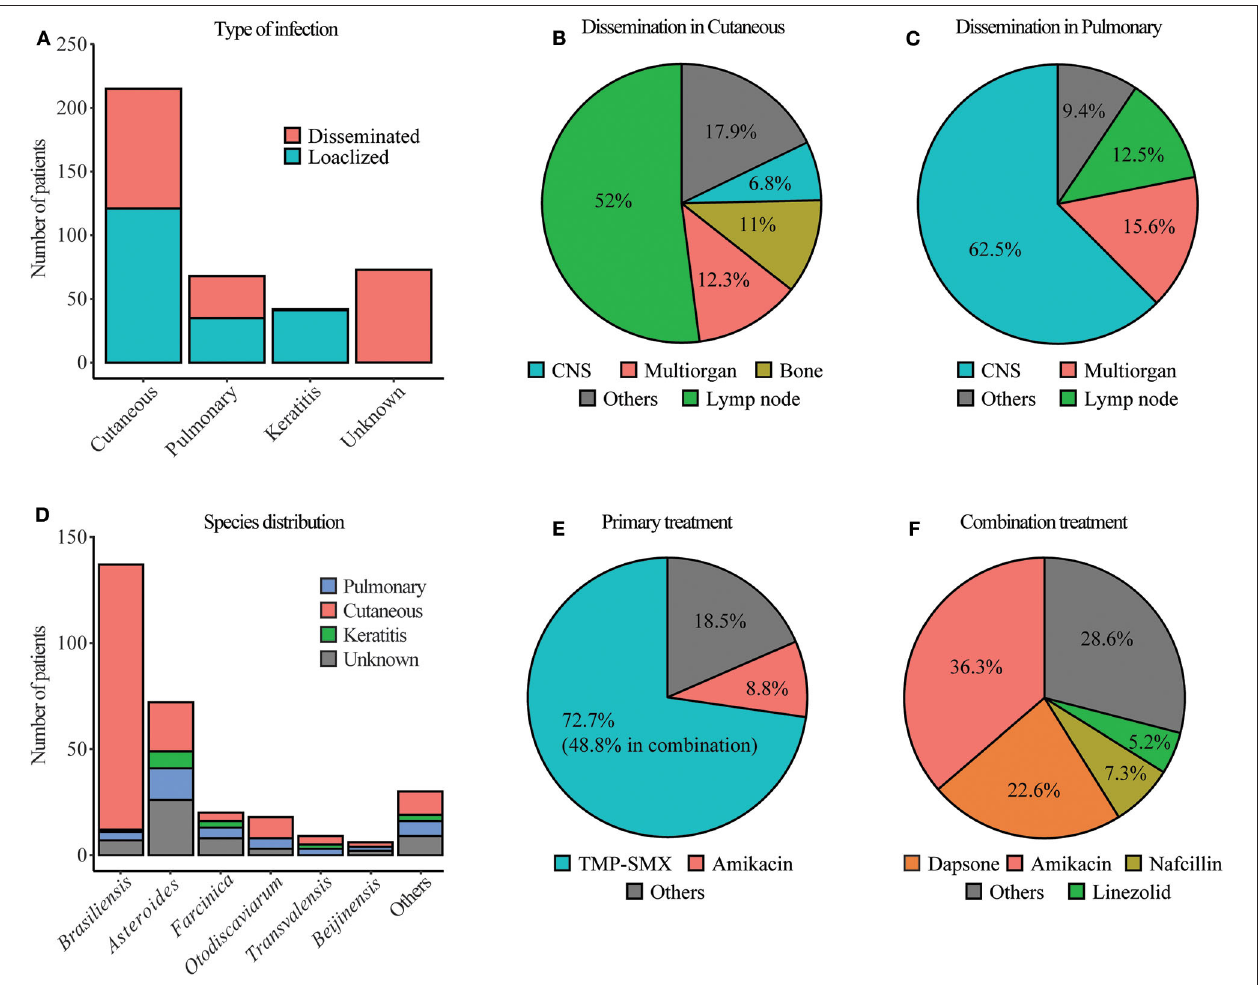
FIGURE 2 | Microbiology, treatment, and kind of infection in patients with isolated nocardiosis. (A) Type of infection of patients with isolated nocardiosis published since 1987. Unknown represent patients with disseminated nocardiosis in which the primary site of infection was not identified. (B,C) Organs, where the disease disseminated in patients with cutaneous nocardiosis in (B) and pulmonary nocardiosis in (C) . Others, represent organs with a frequency of < 5% in this group. (D) Distribution of Nocardia species in the different types of nocardiosis at a frequency of < 5%. Others represent the species present. (E) Primary treatment of patients with isolated nocardiosis. (F) Therapy that was used in combination with TMP-SMX. Others represent the use of drugs at a frequency of < 5%. The information for these figures was obtained from the references (